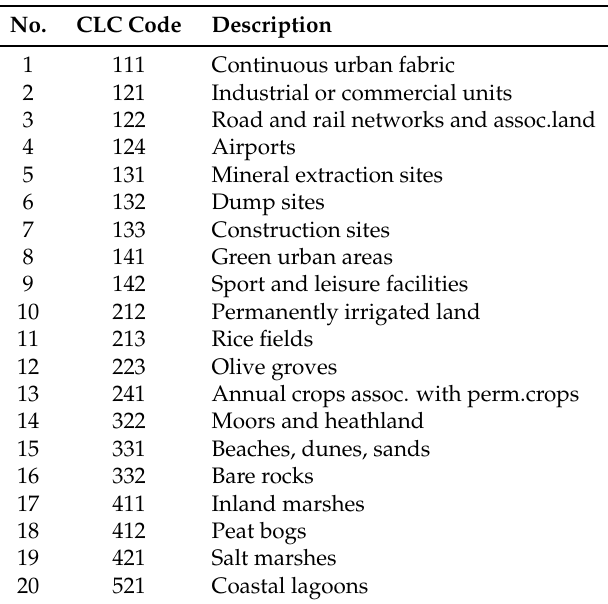
Table 1. Twenty ground-truth CORINE Land Cover (CLC) labels for remote sensing images in the Land Cover dataset.